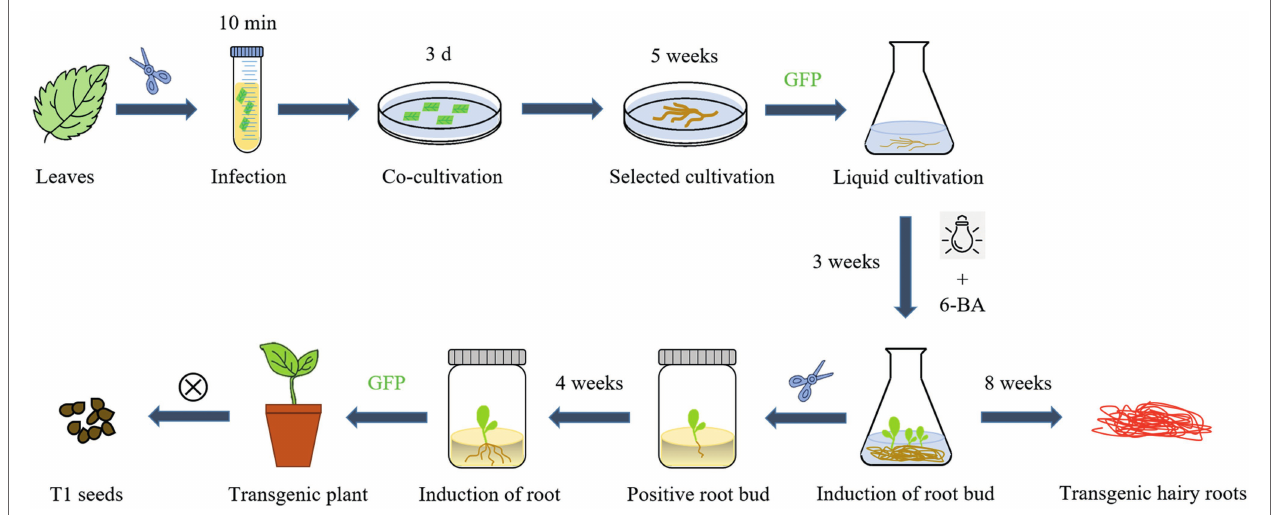
FIGURE 6 | An overview of the main steps for A. rhizogenes transformation and one-step regeneration of S. miltiorrhiza